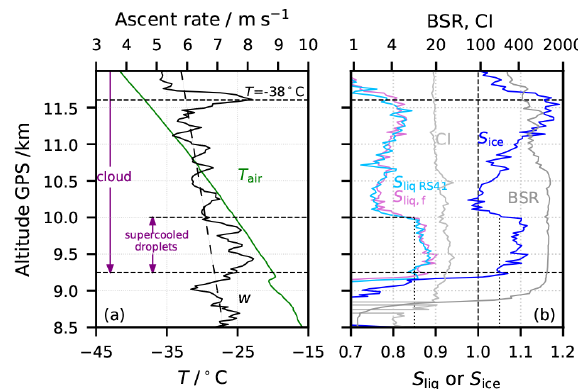
Figure 3. Mixed-phase cloud detail of flight NT011. Lines: 1hPa interval-averaged values. (a) Green: air temperature; black: ascent velocity measured by the RS41 in ms − 1 . (b) Light blue: saturation over water ( S liq , RS41 ) measured by the RS41; pink: saturation over water ( S liq , f ) from the CFH considering the deposit on the mirror to be frost; blue: ice saturation ( S ice ) from the CFH; dark grey: 940nm backscatter ratio from the COBALD; light grey: colour index (CI) from the COBALD. Horizontal dashed lines mark the supercooled droplet region and T air =− 38 ◦